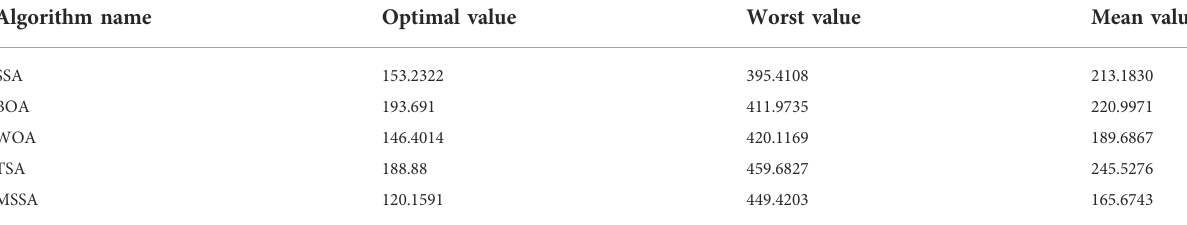
TABLE 10 Statistical data of experimental results in environment